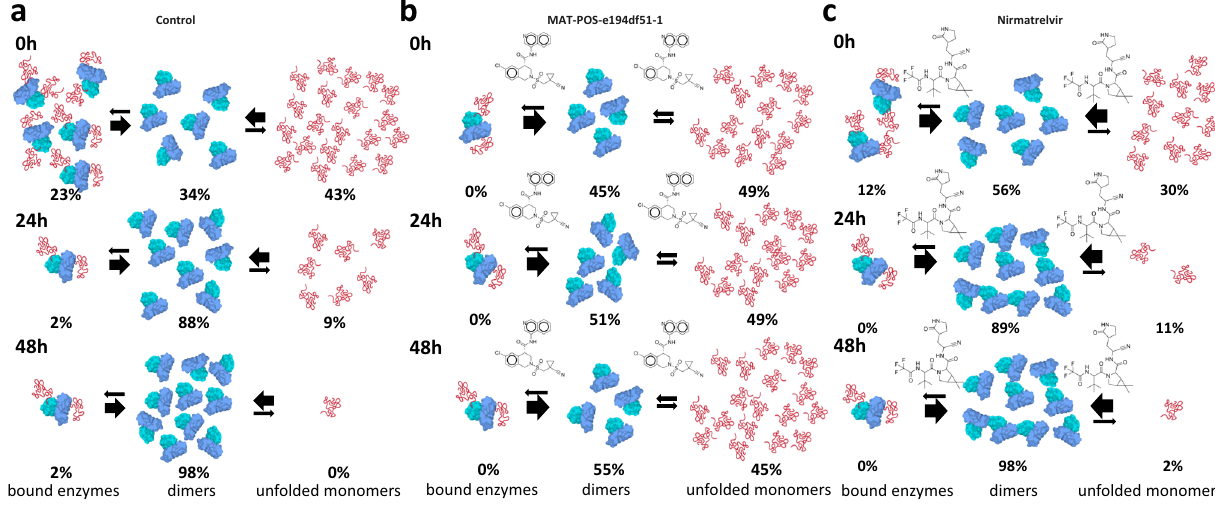
Fig. 6 |Schematicrepresentationofin solutiondynamicsofSARS-CoV-2 C145S M pro tetrameric form (sample 2) analyzed with SEC-MALS. a Control reaction containing tetramers at 0h (top), after 24h incubation (middle) and after 48h (bottom). b Tetramers conversion reaction in presence of non-covalent inhibitor